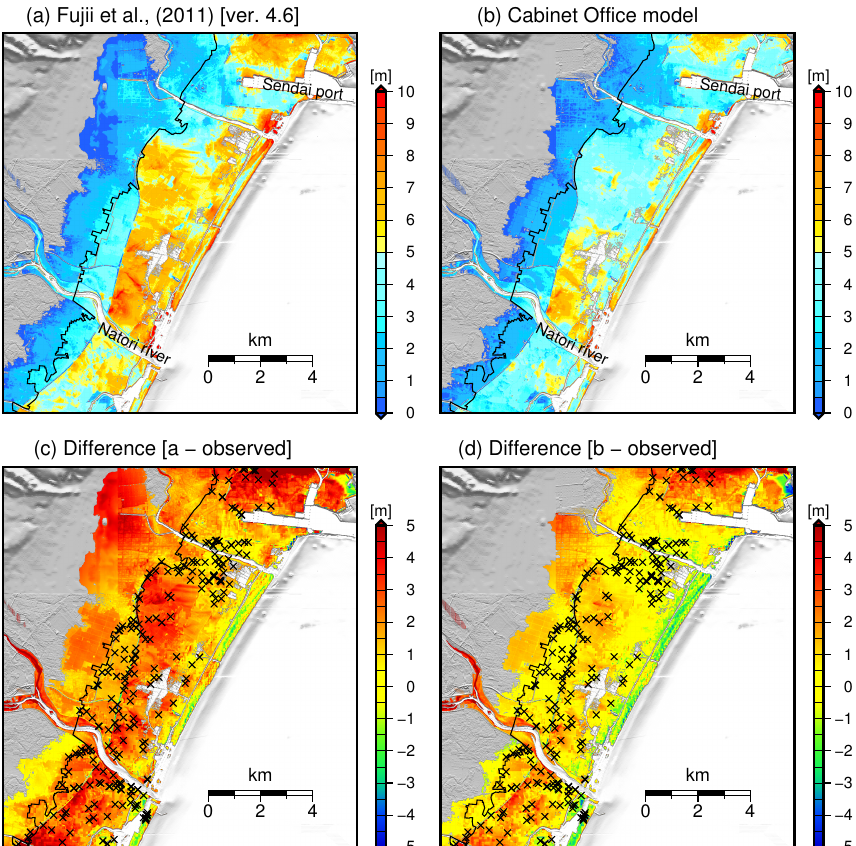
Figure 7. Sendai computational area. ( a ) Maximum inundation depth computed using the tsunami source published by Fujii et al. [1]; ( b ) Maximum inundation depth estimated using the earthquake source developed by the Cabinet Office of Japan ([9]); ( c ) The difference in the maximum inundation depth between the Fujii et al. [1] model and measured inundation depth; ( d ) The difference in the maximum inundation depth between the Cabinet Office [9] model and measured inundation depth. The x symbols show the locations of the JSCE measurements. The black line indicates the inundation limits estimated by the GSI.